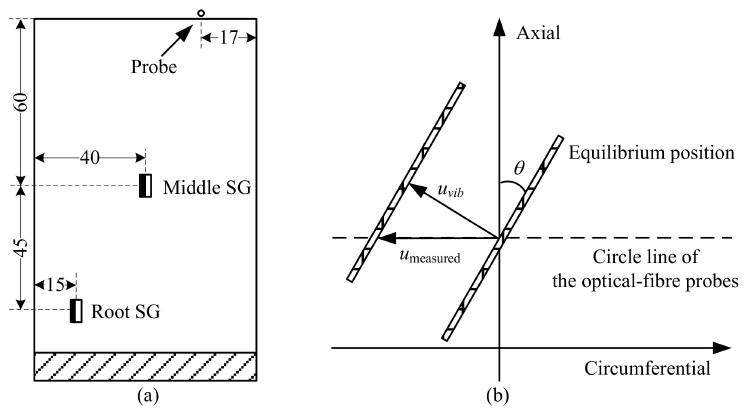
Figure 8. Schematic of strain gauge positions and blade set-ups: ( a ) Positions of middle SG and root SG; ( b ) Blade stagger angle θ